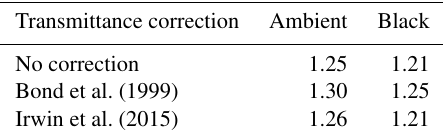
Table 3. Ratio of the light attenuation coefficient measured with Azumi filter to the value measured with Pallflex